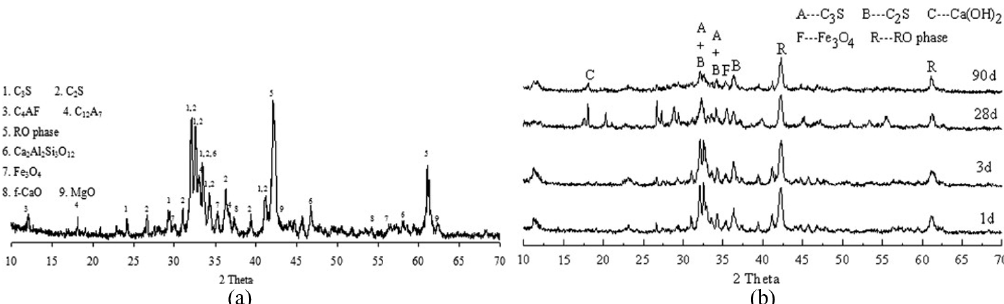
Figure 4. XRD patterns of original steel slag and hydration products of steel slag. ( a ) Original; ( b ) after hydration [59], adapted from [59], with permission from Elsevier, 2021.